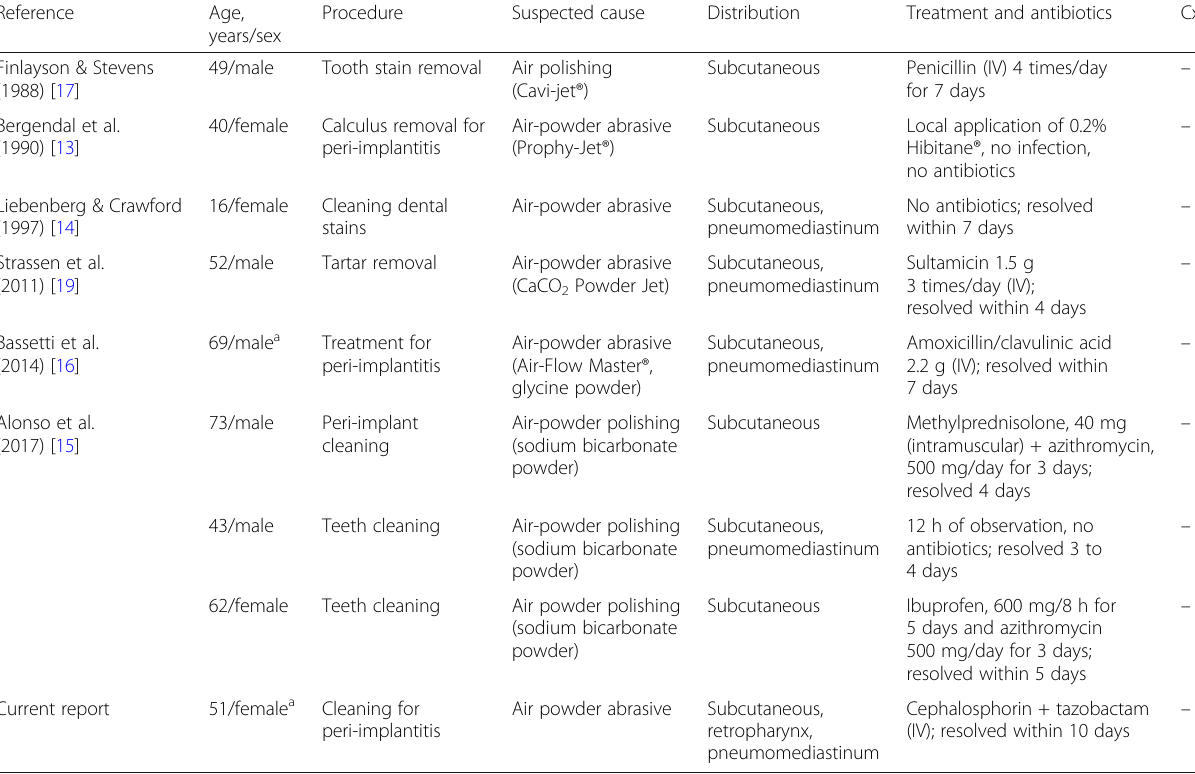
Table 1 Subcutaneous emphysema caused by air-powder instruments (1987 to date)